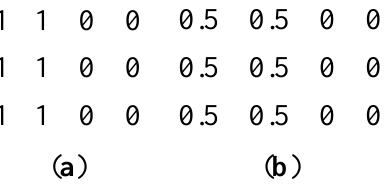
Figure 1. ( a ) Sharp edge and ( b ) Less prominent edge.